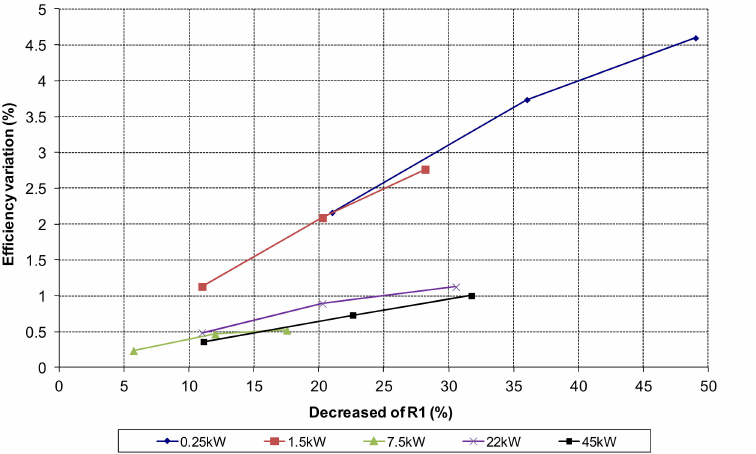
Figure 13. Efficiency variation versus decreased of R 1 in all the motors (equal output power criteria).